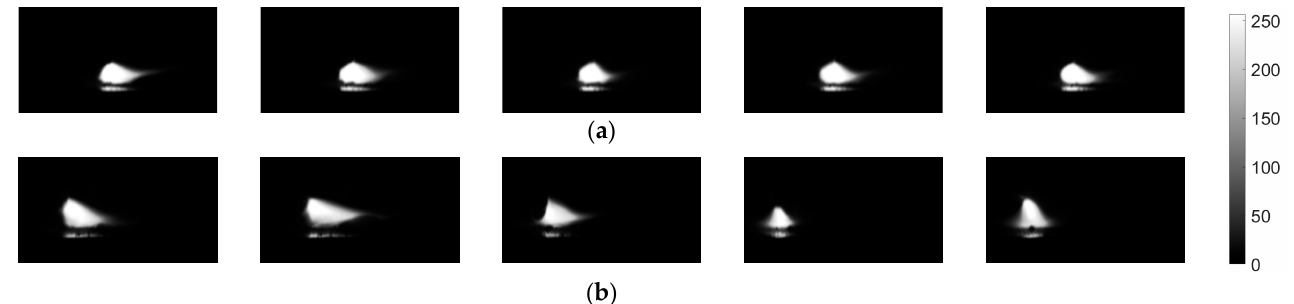
Figure 9. Five consecutive frames representing welding arc luminance taken by the VIS CAM: ( a ) short arc DC(+) cladding; ( b ) short arc DC( − ) cladding.